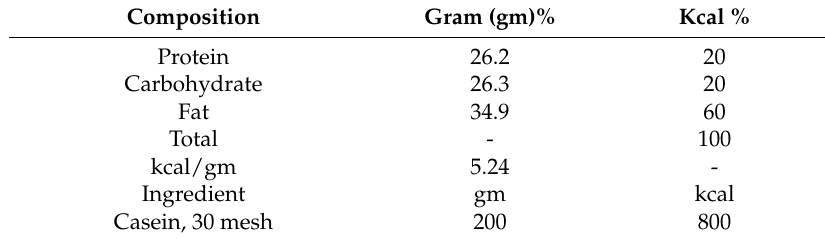
Table 2. Diet Composition of the high-fat diet (cat# D12492, Research Diets, New Brunswick, NJ,